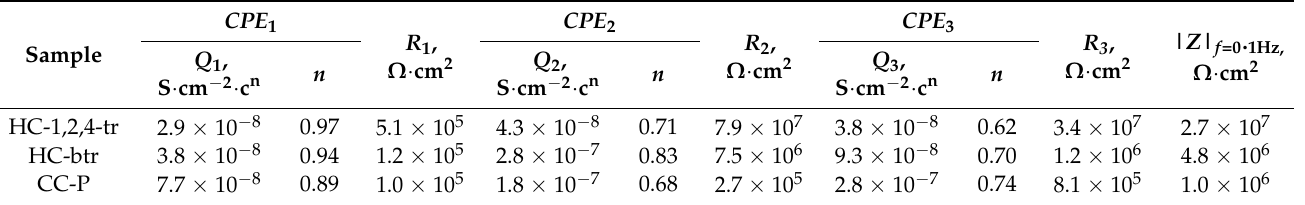
Table 4. The calculated parameters of EEC elements for samples of AlMg3 aluminum alloy with various types of HC formed on the basis of a